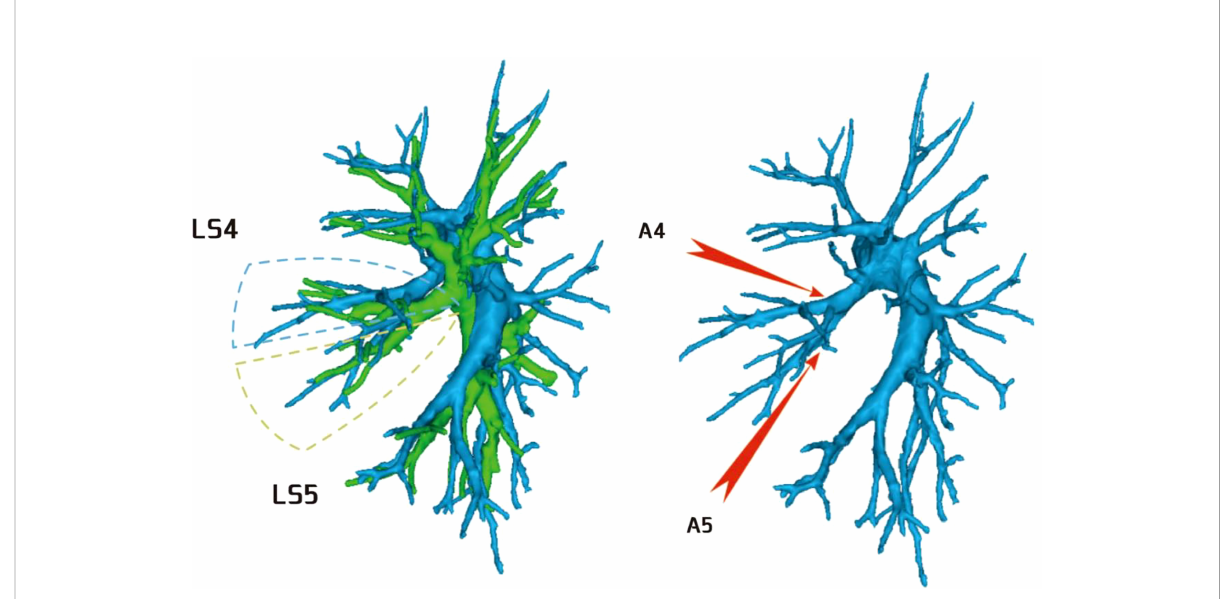
FIGURE 9 A4 + 5 originated from the mediastinal side of the lingular bronchus.